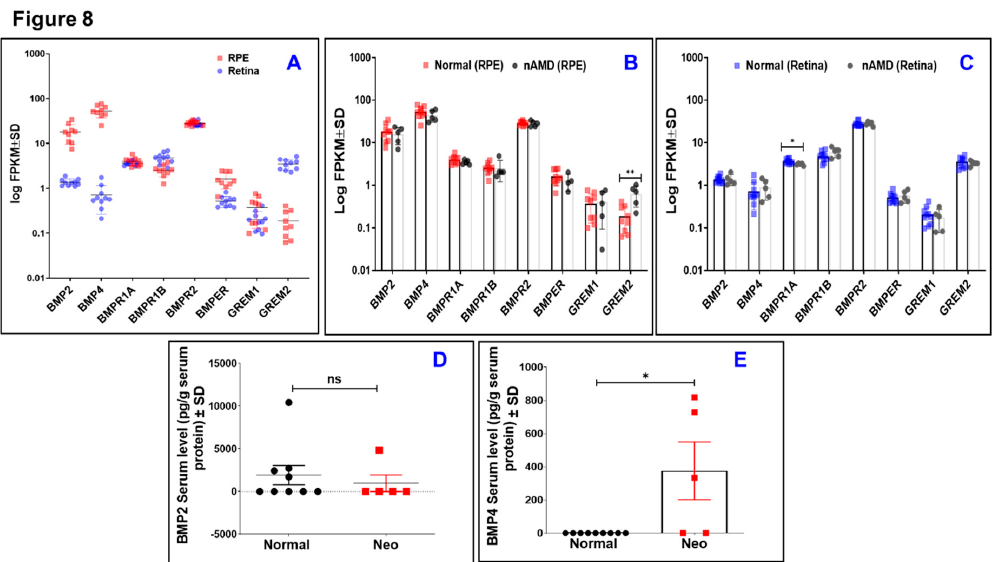
Figure 8. Tissue and circulating levels of BMP-family in donor patients with nAMD. ( A ) Local mRNA expression levels of BMP ligands (BMP2 and BMP4), three BMP specific receptors (BMPR1A, BMPR1B, and BMPR2), and three BMP regulators (BMPER, GREM1, and GREM2) in normal human retina versus RPE/choroid tissues determined by RNA-seq and represented as log of fragments per kilobase per million sequenced reads (FPKM); n = 9–10 per group. ( B ) Log FPKM expression of BMP-family in RPE/choroid from nAMD and normal groups; ** = adjusted P < 0.01 ; n = 5–9 per group. ( C ) Log FPKM expression of BMP-family expression in the retina from nAMD and normal groups; * = adjusted P < 0.05; n = 5–10 per group. ( D , E ) Circulating BMP2 and BMP4, respectively, in serum samples from nAMD donors versus normal donors determined by ELISA Assay. The di ff erence in serum levels of BMP2 and BMP4 has been evaluated by Chi Square test. * represents Chi Square P -Value which was statistically significant ( < 0.05). Results are presented as mean ± SD; n = 5–9 per group. AMD patients (2 males and 3 females; Age 83 ± 6.5) and Controls (6 males and 4 females; Age 74 ±